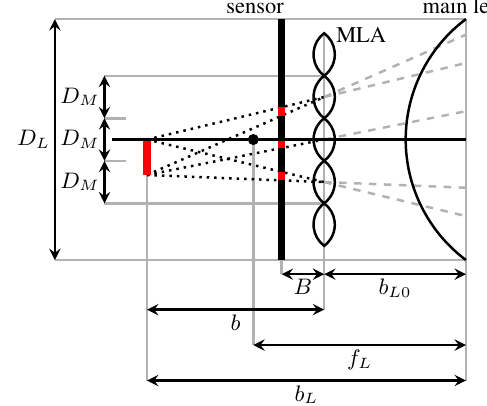
Figure 2. Optical path inside a Raytrix camera. The virtual image which would occur behind the sensor in the distance b L to the main lens is projected by the MLA to multiple micro images on the